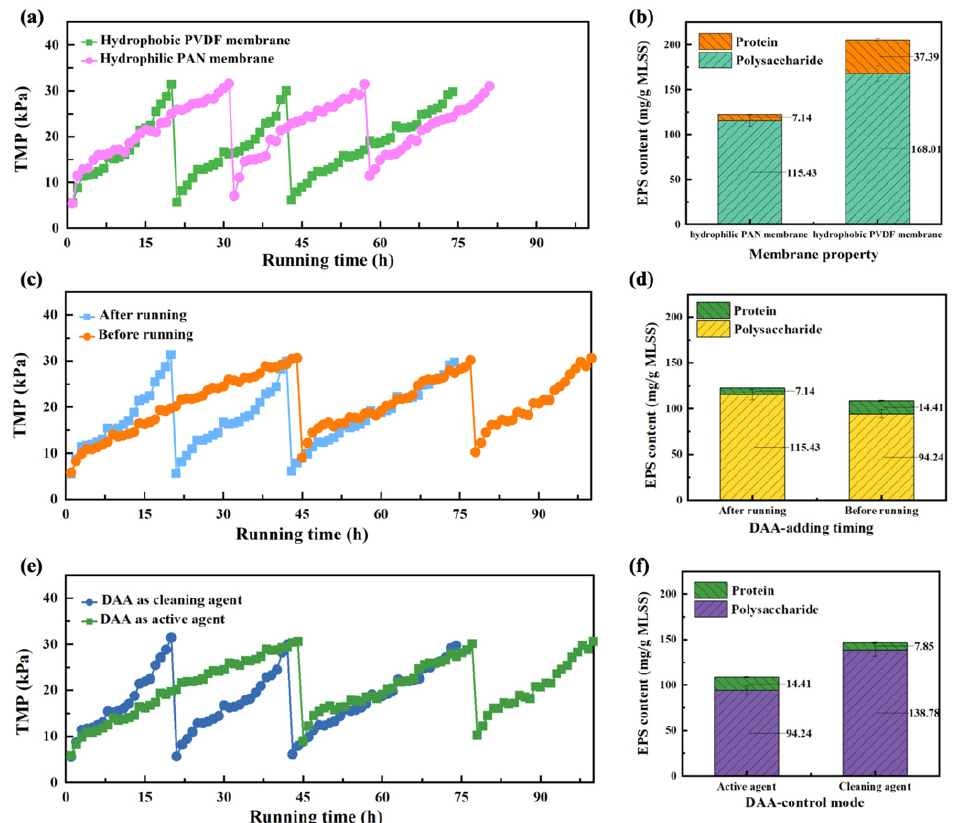
Figure 3. TMP variation with running time and EPS analysis for the MBR with different DAA con- trol ways: membrane property ( a , b ); DAA-adding timing ( c , d ); DAA-control mode ( e , f